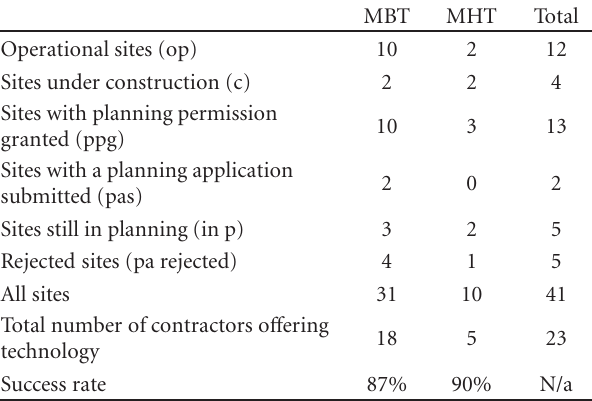
Table 1: Overview of MBT and MHT sites.